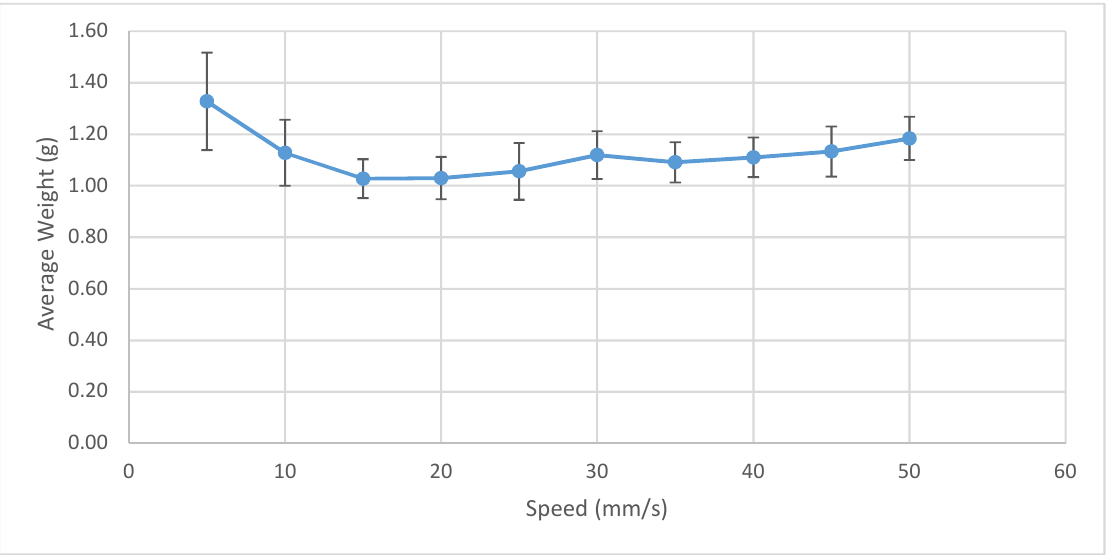
Figure 4. PC average mass as a function of the print speed.